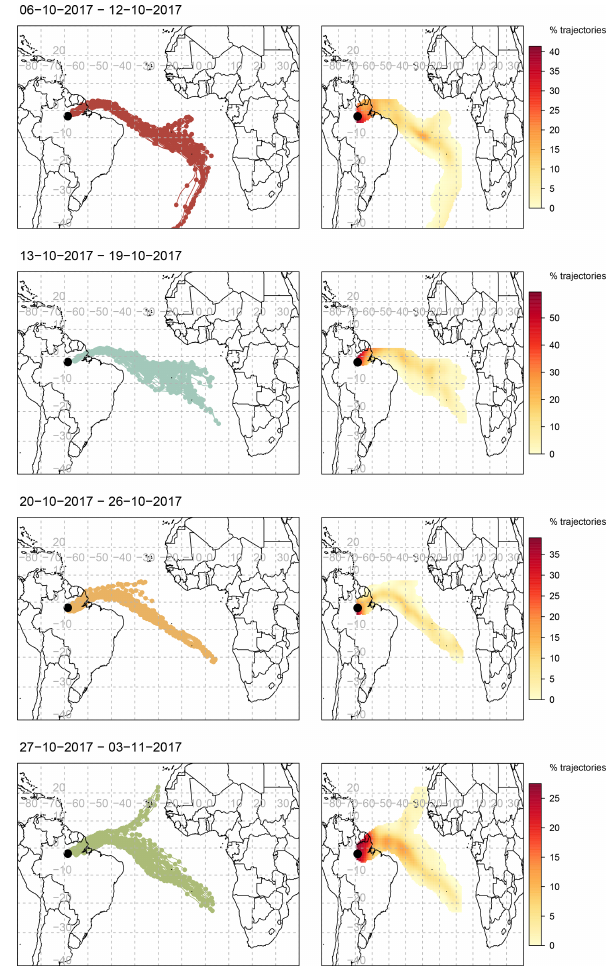
Figure 11. Air-mass back-trajectories arriving at the 80m walk-up tower on each day every 3h from 00:00 local time over the period from 6 October to 3 November 2017, grouped by week, and coupled with associated frequency trajectory plots. The duration of each tra- jectory is 10d, marks indicate 12h intervals. Modelled using NOAA HYSPLIT-4 using GDAS1